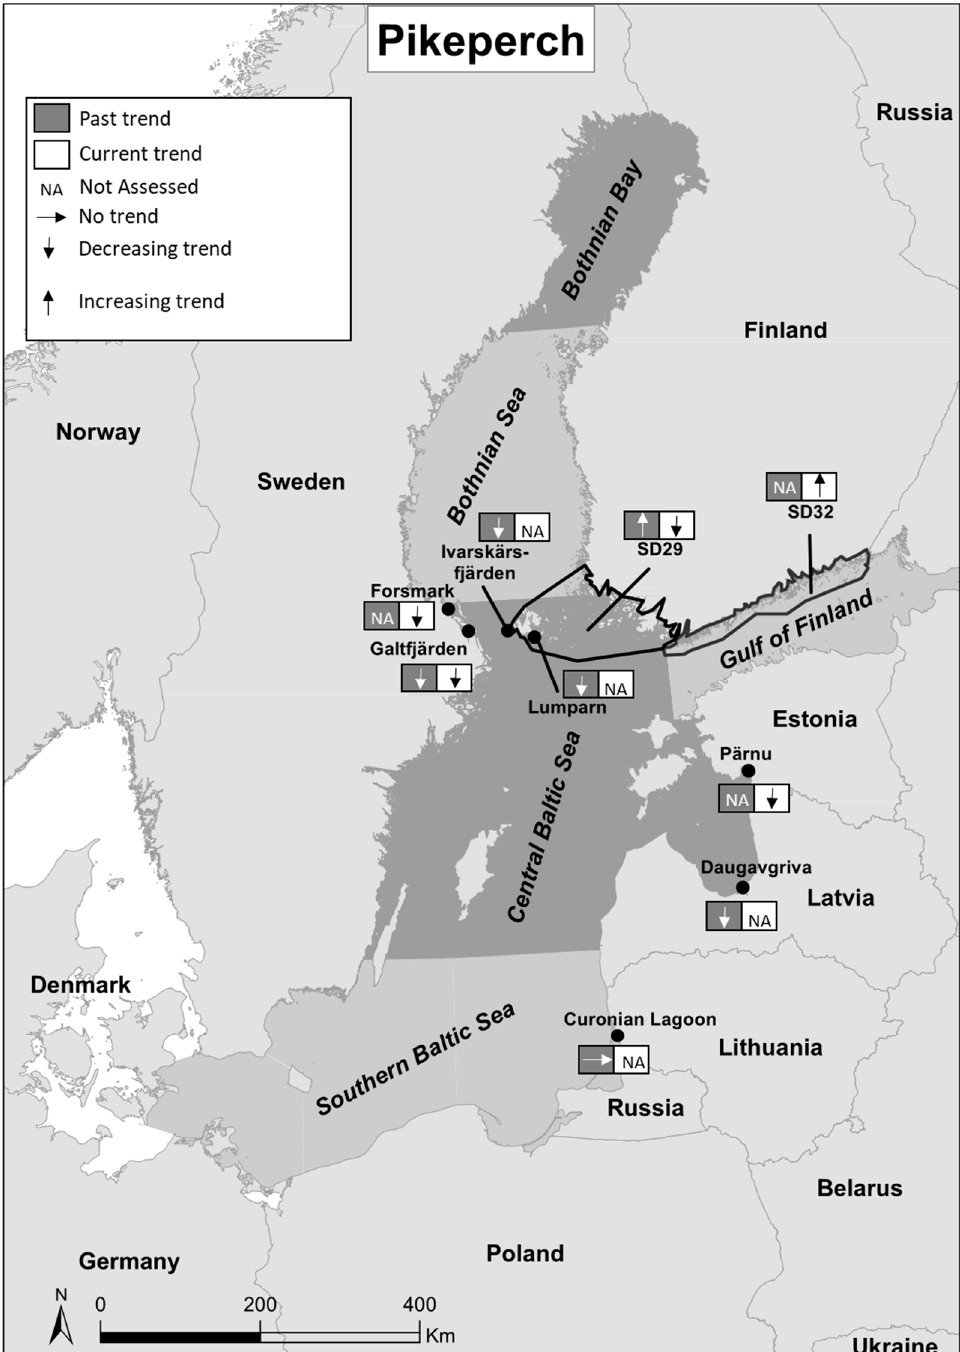
Figure 5. Overview of the trends in abundance of pikeperch for the few areas in the Baltic Sea for which information (publications and national status assessments) are available. An up-ward pointing arrow denote increasing trends in abundance, a horizontal arrow no trend in abundance, and a down-ward pointing arrow a decreasing abundance. NA denotes that no assessment/data is available. For each area, past trends are shown in a grey box and current trends in a white box. Time-period considered in each area and box are outlined in the main text and in Table 4.